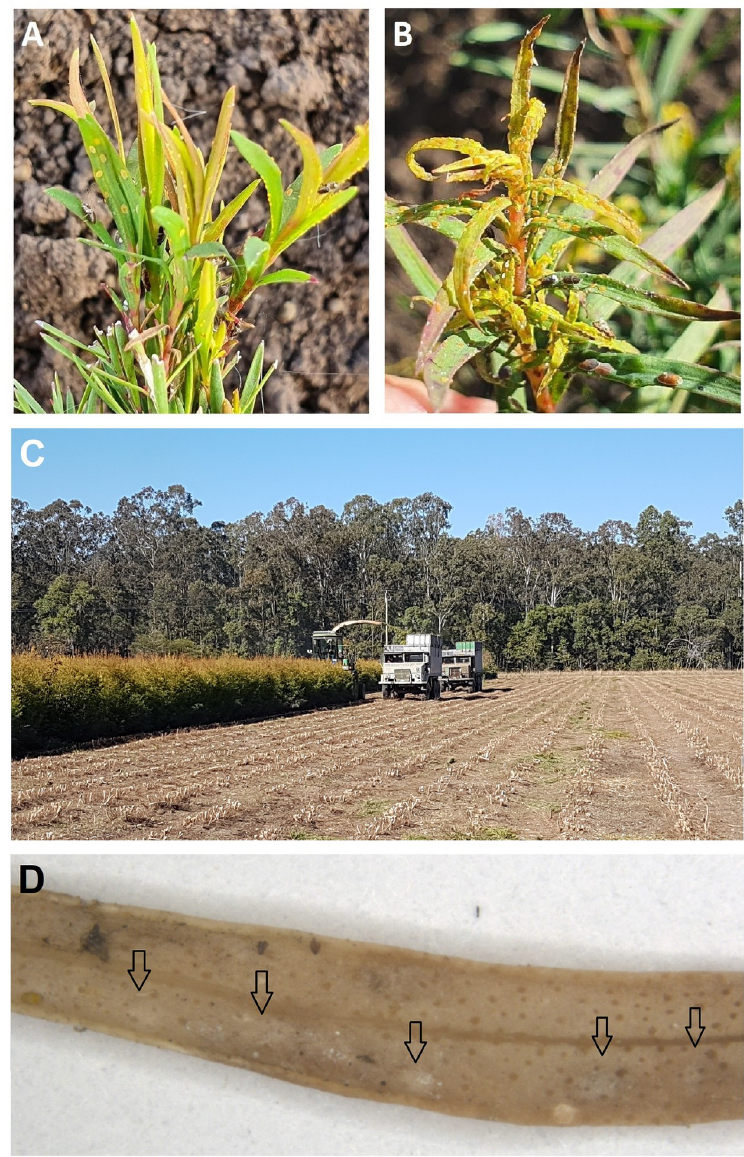
Fig 8. Melaleuca alternifolia attacked by Trioza melaleucae . The initial infestation with adult psyllids and very young nymphs ( A ) can be compared to the final stages of the infestation, with larger 5 th instar nymphs causing leaves curling ( B ). Yearly, M . alternifolia is harvested (left) removing any biomass present above ground (right) ( C ). Pitting on the leaves are highlighted by arrows ( D ). Photos courtesy of Peter Entwistle and Tony